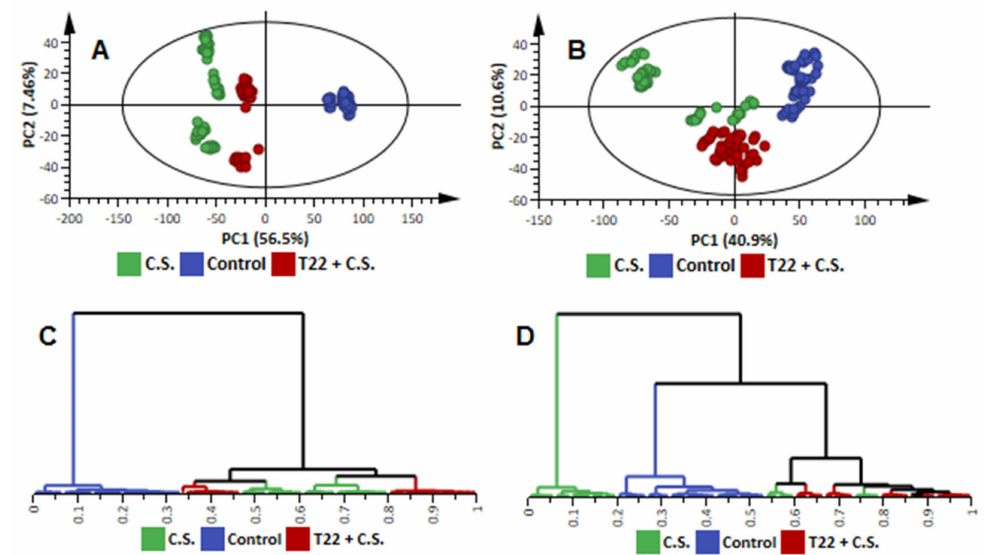
Figure 2. Exploratory data analysis with unsupervised chemometric methods. ( A ): A PCA scores scatter plot computed from the first two PCs of a model of ESI( + ) data of all time points combined. The data matrix is presented as an eleven-component (R1 significance) model, explaining 79.5% variation in the Pareto-scaled data and the amount of predicted variation by the model, according to cross-validation, is 72.7%. ( B ): A PCA scores scatter plot computed from the first two PCs of a model of ESI(-) data, X: an eleven-component (R1 significance) model, explaining 73.6% variation in the Pareto-scaled data and the amount of predicted variation by the model, according to cross-validation, is 65.9%. ( C , D ) are HCA dendrograms corresponding to ( A , B ), respectively. The ellipse in the PCA scores plots represents the multivariate generalisation of the 95% confidence interval (Hotellings T 2 ), the normality area, which is used to visually identify strong outliers. Corresponding data from the ESI(-) mode, indicating the di ff erent time points, is shown in Figure